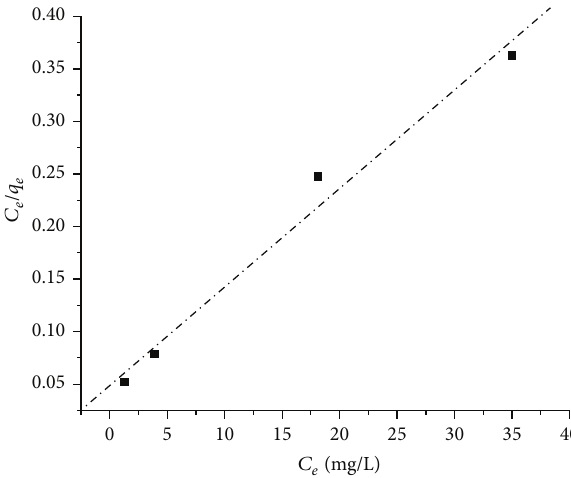
Figure 6: Langmuir isotherm model of Hg(II) sorption onto ALP biomass (at 303 K, pH 6.0).